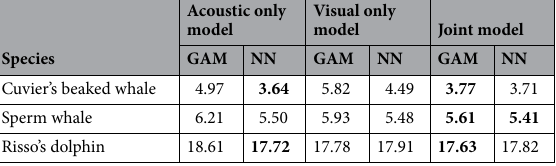
Table 3. Root mean squared error (RMSE) scores for density models. Best-fitting models highlighted in bold.